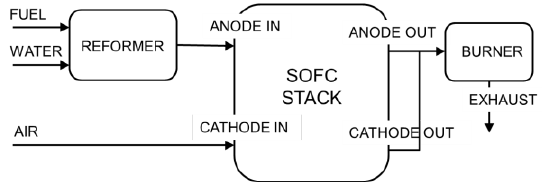
Figure 5. Schematic of the SOFC plant.